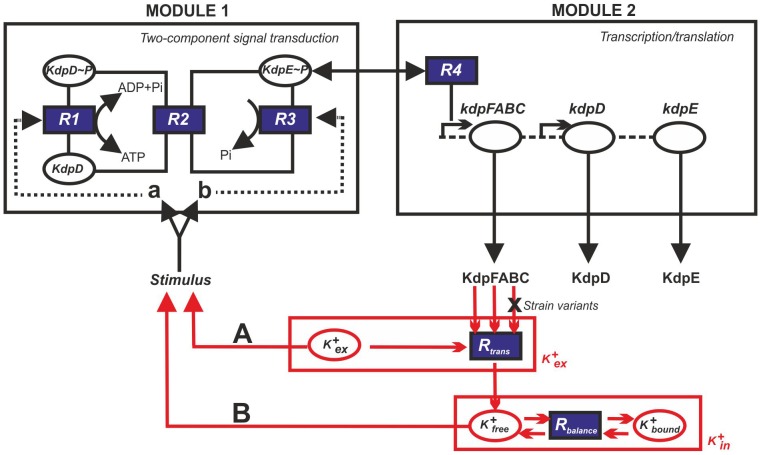
Basic scheme used to construct the mathematical model of the Kdp system.The model is made up of two modules: two-component signal transduction and transcription/translation. The input to the first module is the activating stimulus for KdpD, which results in phosphorylated KdpE, the input to the second module. The output of this module is the production of KdpFABC. The two modules are also linked by a feedback loop from KdpFABC to the KdpD/KdpE system with K+ as the mediator. This model reflects the uptake of external K+ (K+
ex) by KdpFABC and the concomitant effects on the balance of intracellular K+ in the bound (K+
bound) and free form (K+
free). Two potential primary stimuli for KdpD are considered: the external K+ concentration (A) and the internal K+ concentration (B). Furthermore, K+ may affect either the kinase (a) or the phosphatase activity (b) of KdpD.